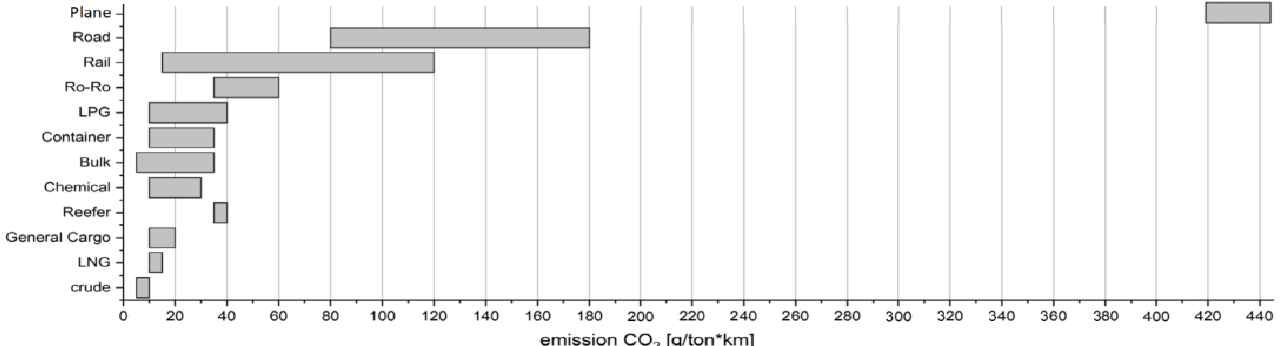
Figure 1. Illustration of CO 2 emission in the environment depending on the means of transport (adjusted from [4]).